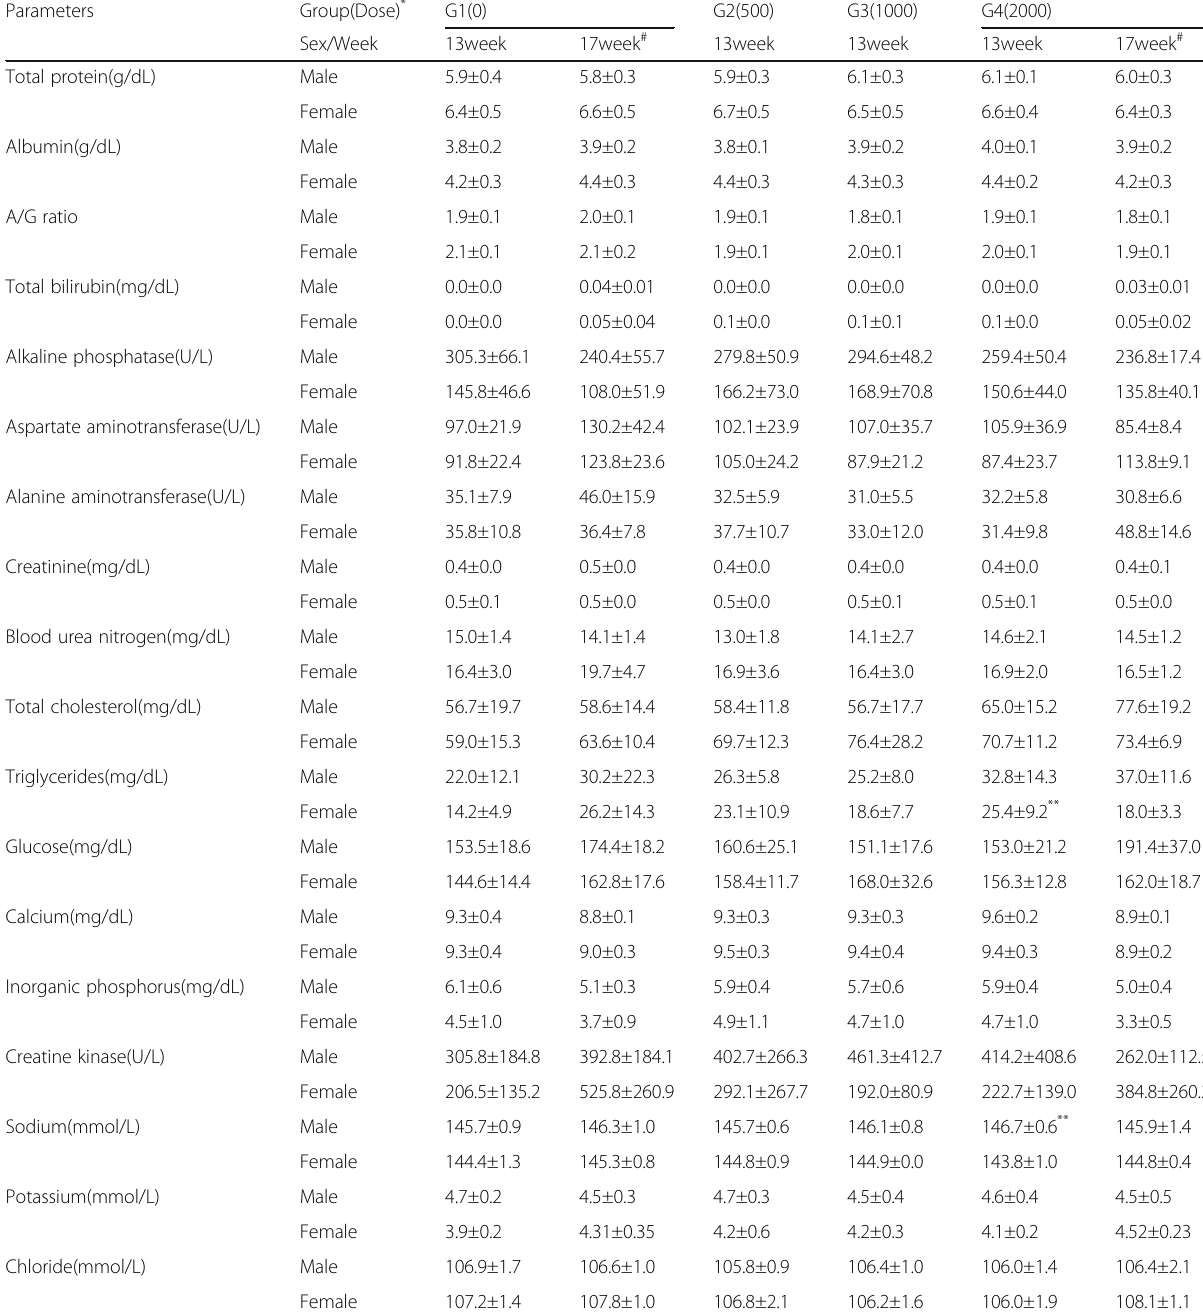
Table 6 Blood chemical parameters